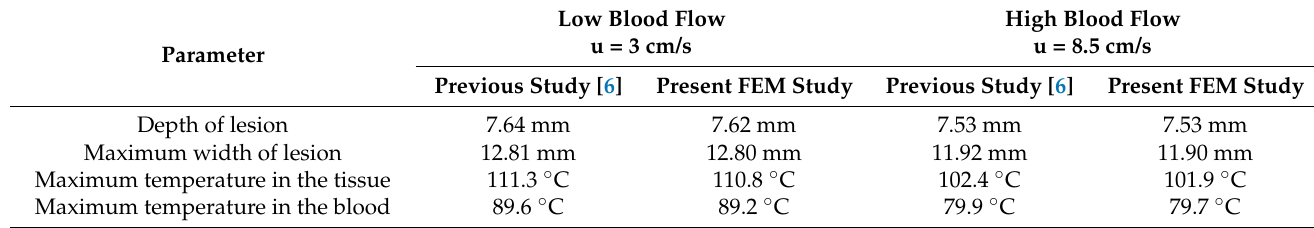
Table 2. Validation of the predicted results of current model with that of [6].